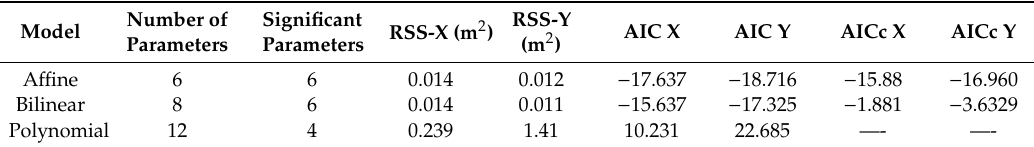
Table 6. Number of parameters, significant parameters, residuals sum of parameters (RSS), and values of AIC and AICc for each model.